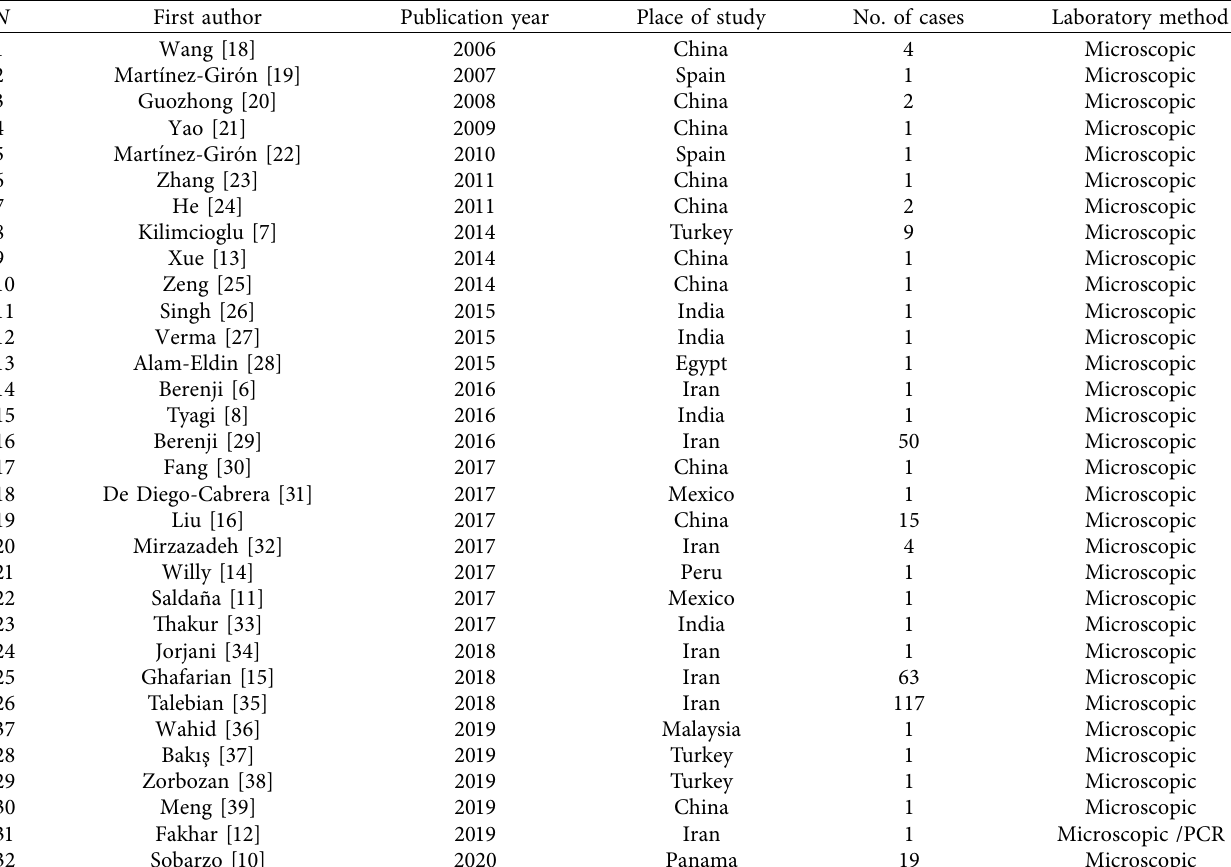
Table 1: Baseline characteristics of the included studies in the systematic